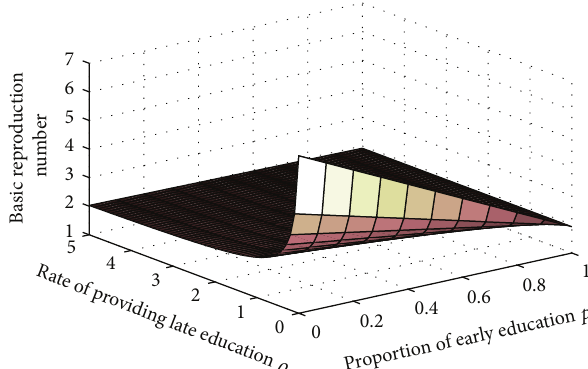
Figure 3: The basic reproduction number for the model of testing with limited education (29) as a function of two variables: the rate of late education before treatment ( 𝜌 𝑒 ) and proportion of early education ( 𝑝 ). It is clear that this program does not eradicate the disease since > 1 always. Thus education alone is 𝑅 0 𝑛𝑒